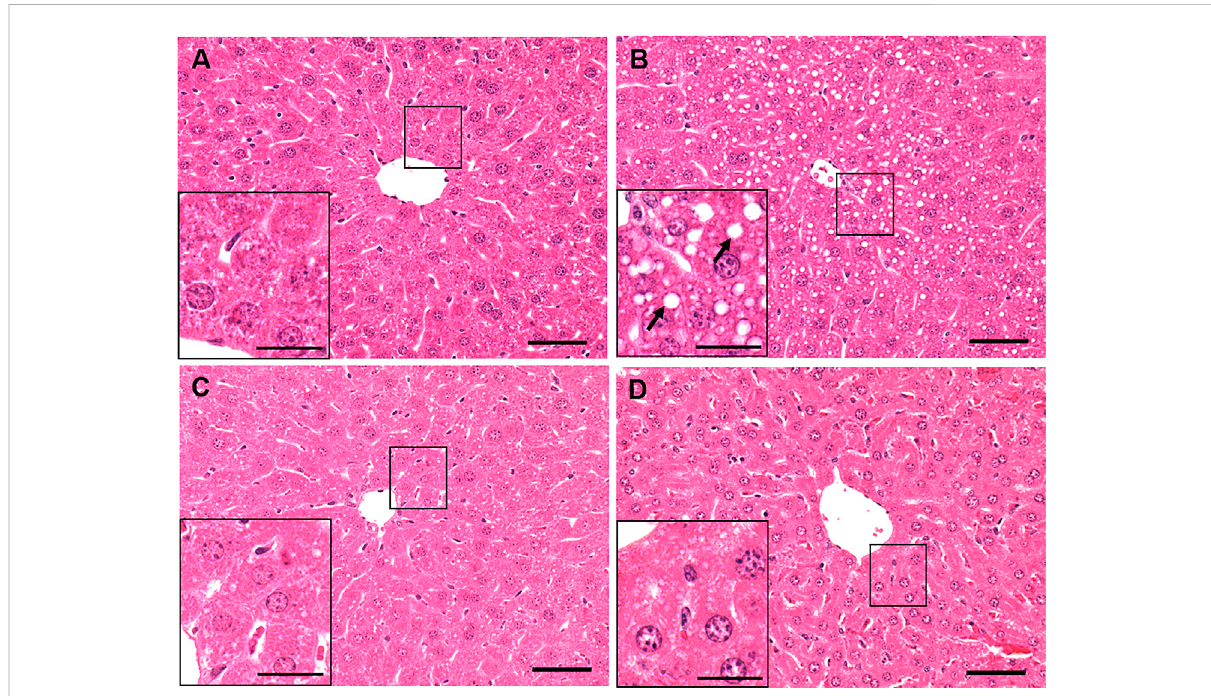
FIGURE 2 Histological assessmentof liverpathologybyhematoxylin andeosin (Hand E)stainingofarepresentativeliver sectionofmice gavaged with (A) saline, (B) ethanol (C) , given betaine 2 h before ethanol (EB-1) or (D) simultaneously with the ethanol binge (EB-2). Macrovesicular lipid droplets (arrows) illustrating fat accumulation is seen only in theliver section of ethanol-fedrepresentative mouse. Scale bar = 50 µm(magni fi edimagescale bar = 20 µm).